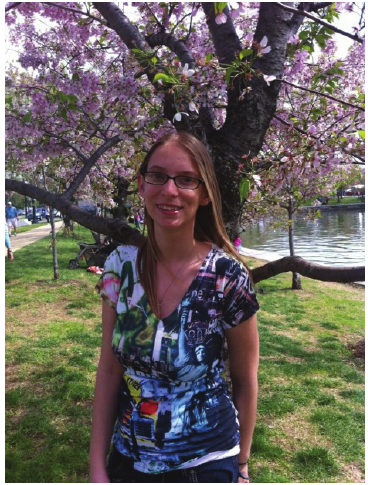
Figure 2. Kayla enjoying the cherry